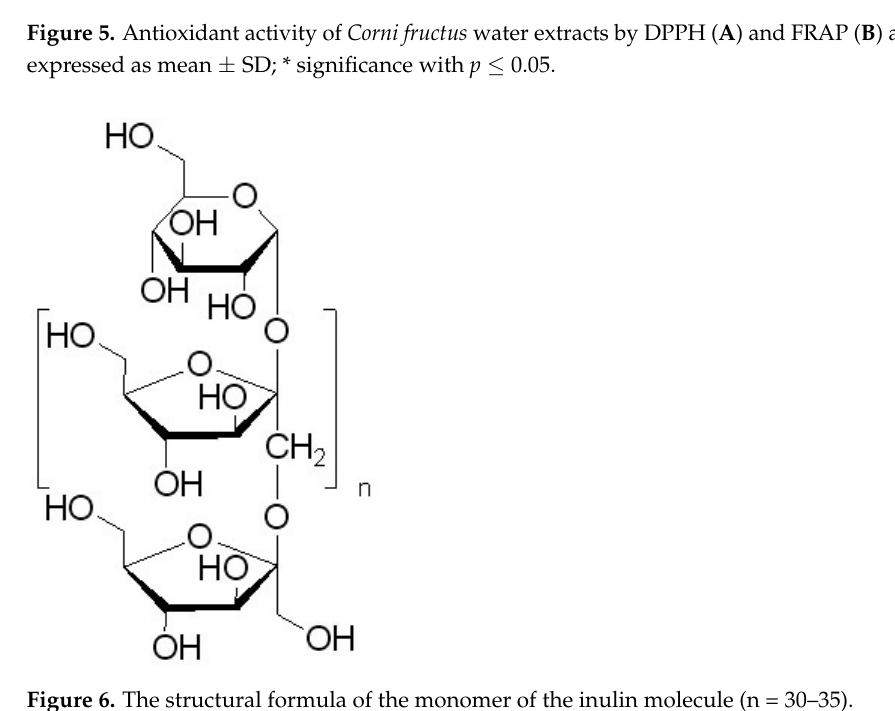
Figure 6. The structural formula of the monomer of the inulin molecule (n = 30–35).